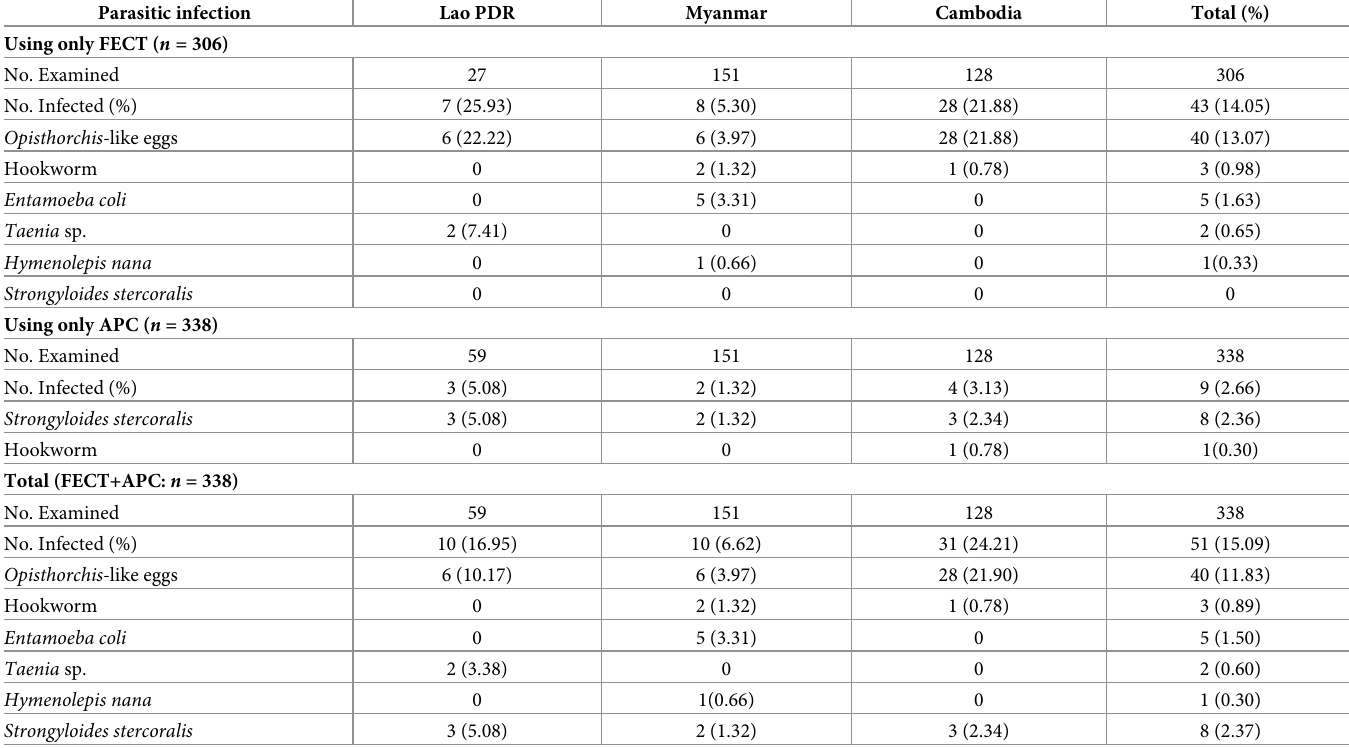
Table 2. Intestinal parasitic infections among 338 immigrant workers in Nakhon Ratchasima Province, northeastern Thailand detected using FECT and APC methods. Parasitic